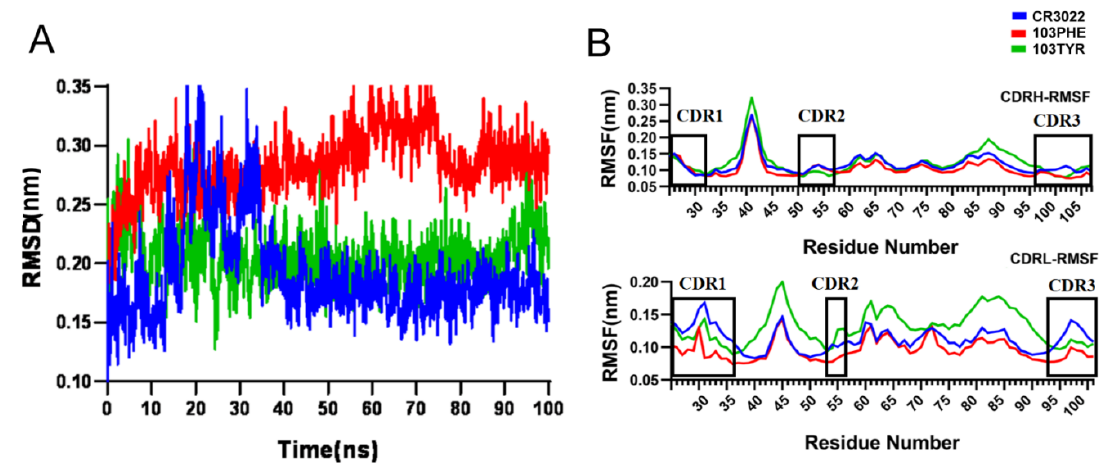
100 µ g/mL, respectively.